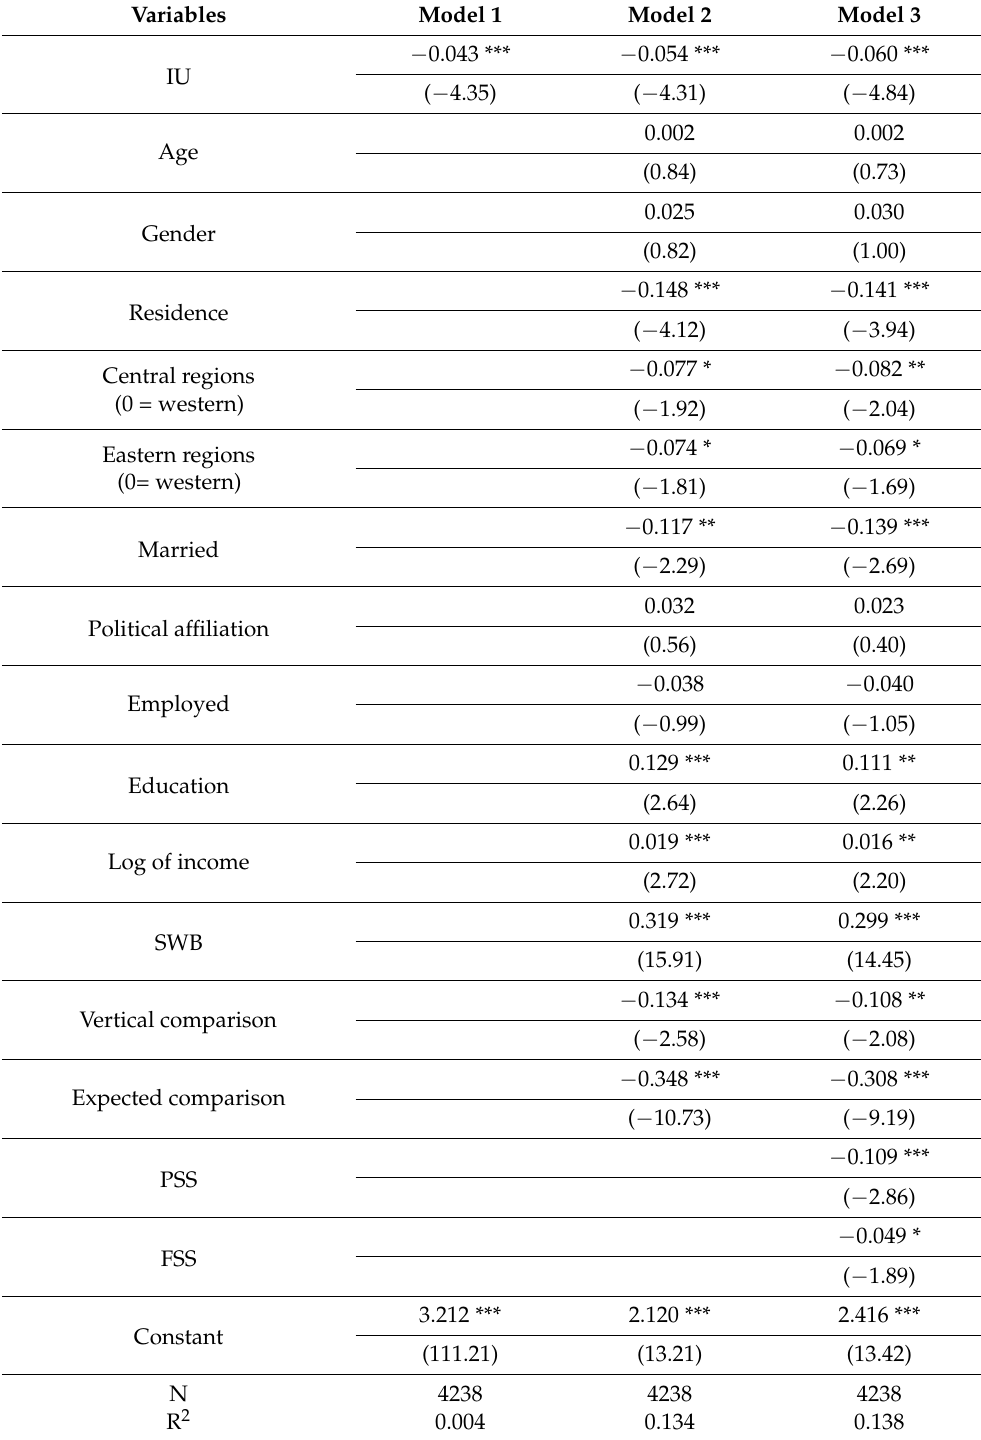
Table 2. OLS estimates of the effect of IU on SFP among the